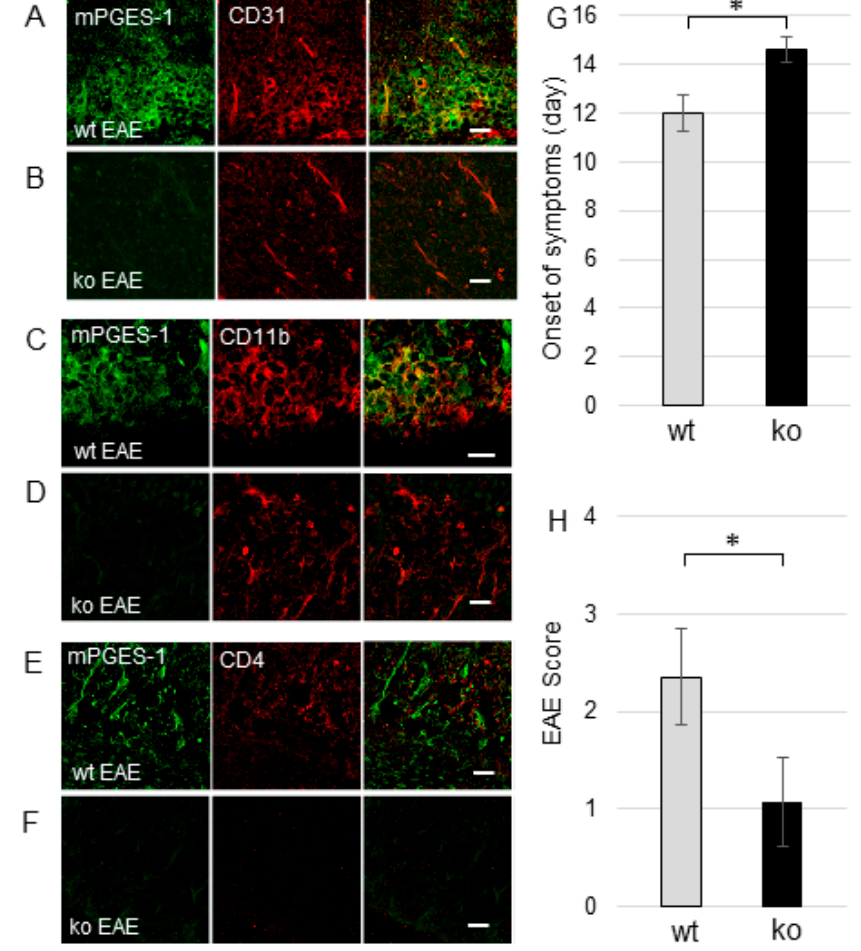
Figure 1. Expression of microsomal PGE 2 synthase-1 (mPGES-1) and the effect of mPGES-1 on experimental autoimmune encephalomyelitis (EAE) paralysis. Immunohistochemistry image of mPGE-1 (green) with CD31 ( A , B ), CD11b ( C , D ), and CD4 ( E , F ) in the inflammatory region of spinal cords of wt EAE mice ( A , C , E ) and ko EAE ( B , D , F ) mice. Onset of symptoms ( G ) and the EAE score at day 19 ( H ) in EAE development. Scale bars (20 µ m) for all images. wt, wild-type; ko, mPGES-1 − / − . * p < 0.05.